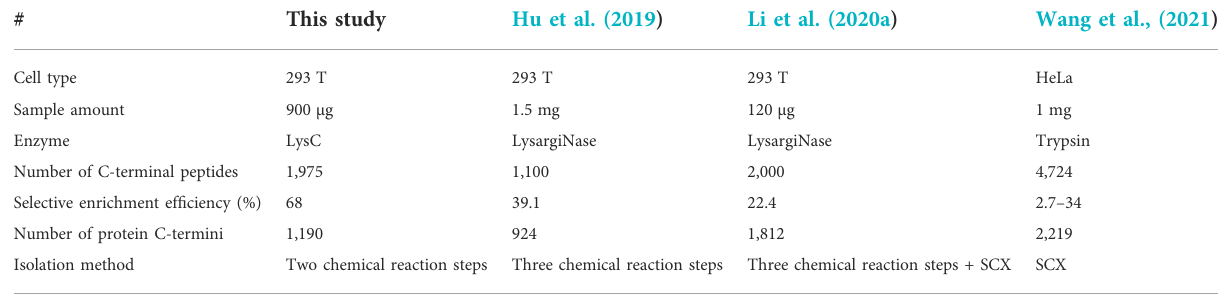
TABLE 1 Comparison the results of human protein C-terminomics studies. # This study